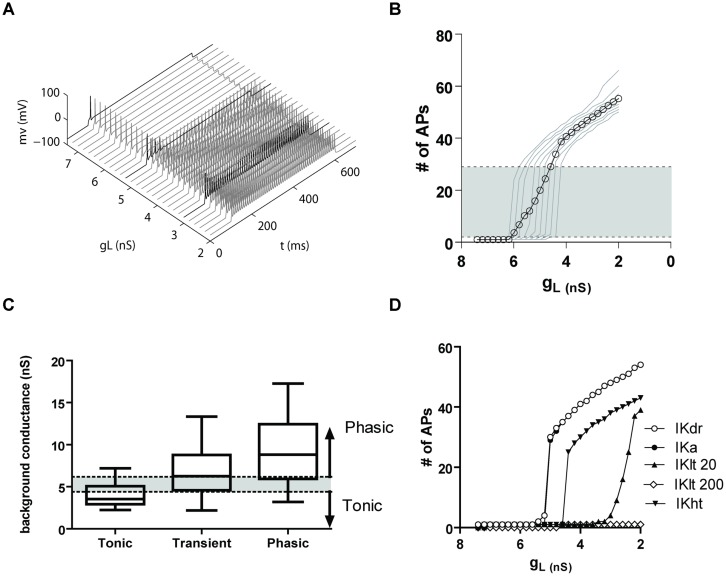
(A) A computer model shows that a potassium leak conductance is sufficient to switch firing from tonic to phasic. (A) Firing of a model phasic NCM neurons with a range of potassium leak conductances (gL), from 7.6 to 2 nS. The darker traces show examples of phasic, transient and tonic firing. (B) Graph showing the number of APs fired by the model vs. the leak conductance. The light traces represent different IKdr levels of conductance (from 60 to 140% of the average IKdr conductance of a phasic neuron), and the open symbols the average. The shaded area represents the transient firing expression, being phasic firing expressed below and tonic firing above it. (C) Comparison of the background conductances of the different neuronal types obtained from the data in Figure 3B with the data from the model. The box and whisker plot represents the 25–75% percentiles of the experimental data, and the bars the minimum and maximum points. The shaded area shows the levels of background conductance producing transient firing and the arrows the conductance levels producing phasic (above) and tonic (below) firing in the model. (D) Plot showing of the number of APs fired vs. leak conductance in a model with the average VAKC from a phasic neuron (IKdr) and adding an A-type potassium current (IKa), a 20 nS low-threshold potassium current (Klt 20), 200 nS of IKlt (IKlt200) and a high-threshold potassium current (IKht).